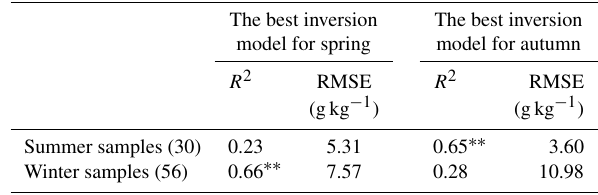
Table 3. Application of the best SSC inversion models. The best inversion The best inversion model for